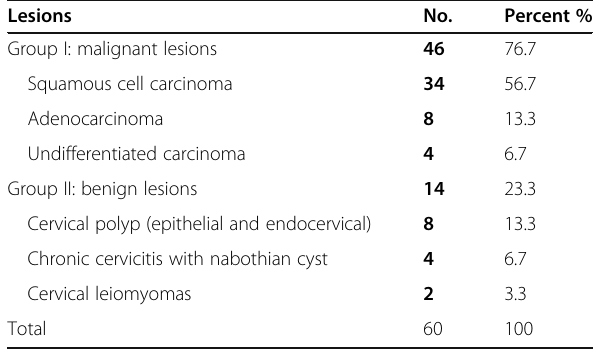
Table 1 Histopathological results of the studied 60 lesions Lesions No.